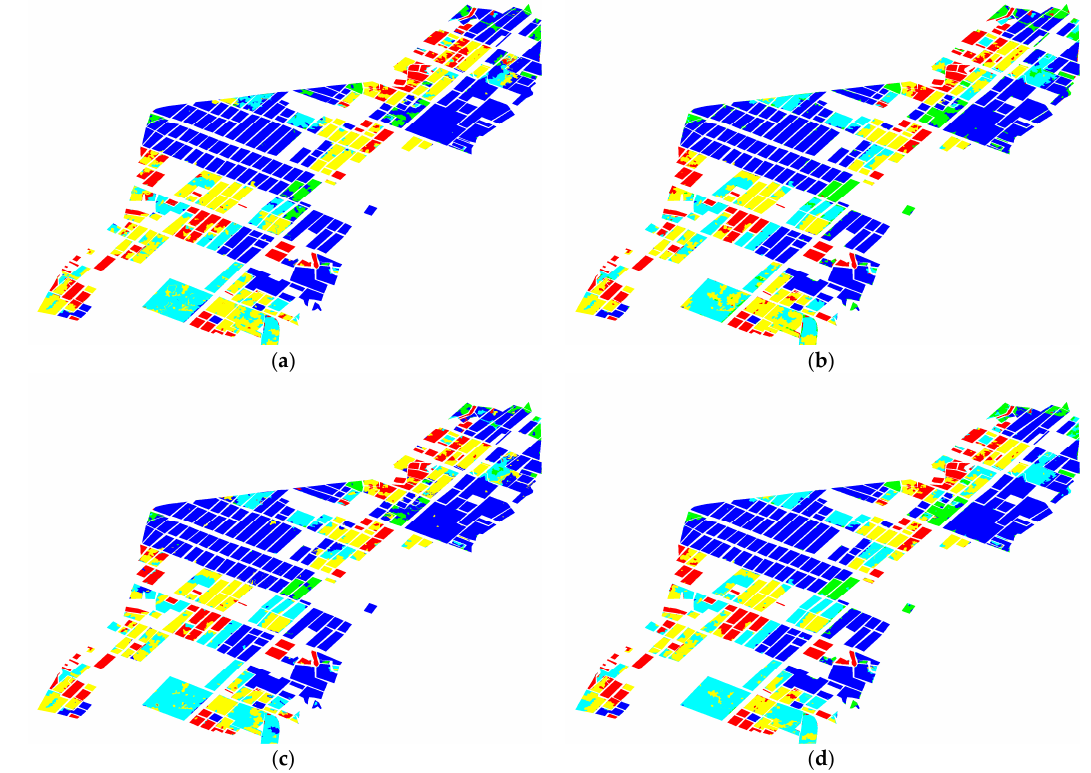
Figure 12. Classification results for the UAVSAR imagery with the different classification algorithms: